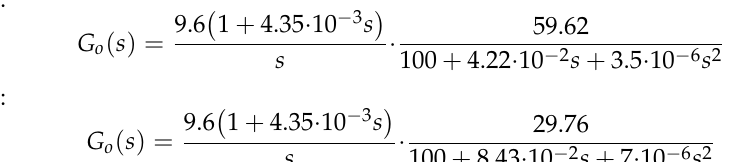
Figure 10. Control block diagram.